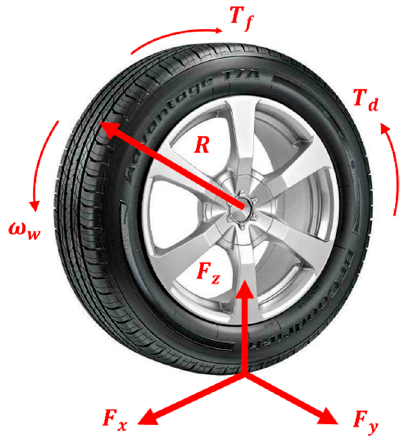
Figure 2. Schematic diagram of the wheel dynamics equation.